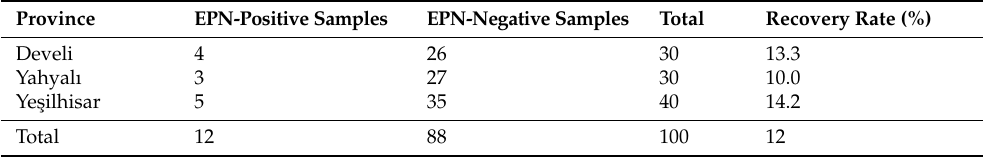
Table 1. Soil samples collected from apple-growing areas of Kayseri Province. Province EPN-Positive